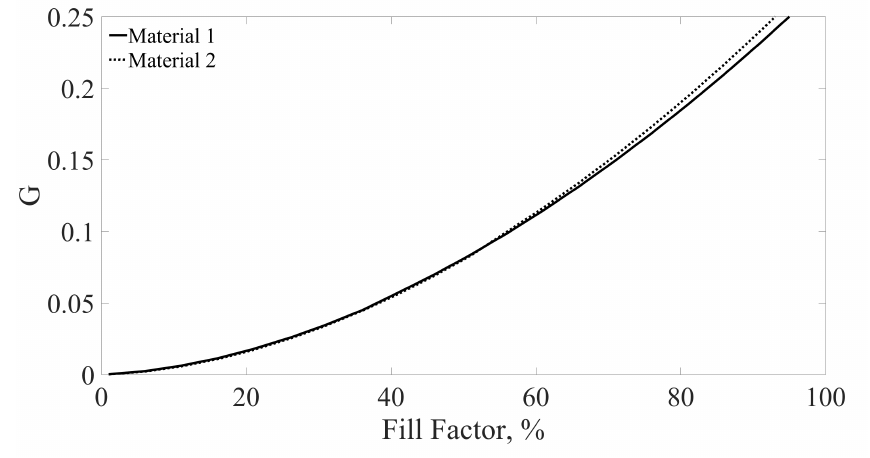
Figure 13. Cost functional as a function of the TEG fill factor.